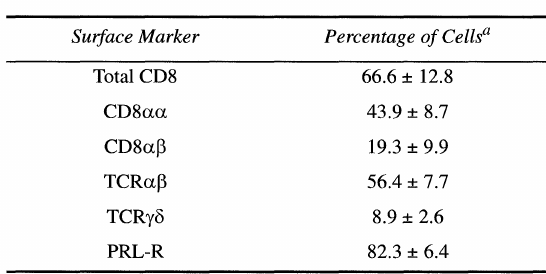
TABLE Phenotype of rat small intestine IEL Surface Marker Percentage of